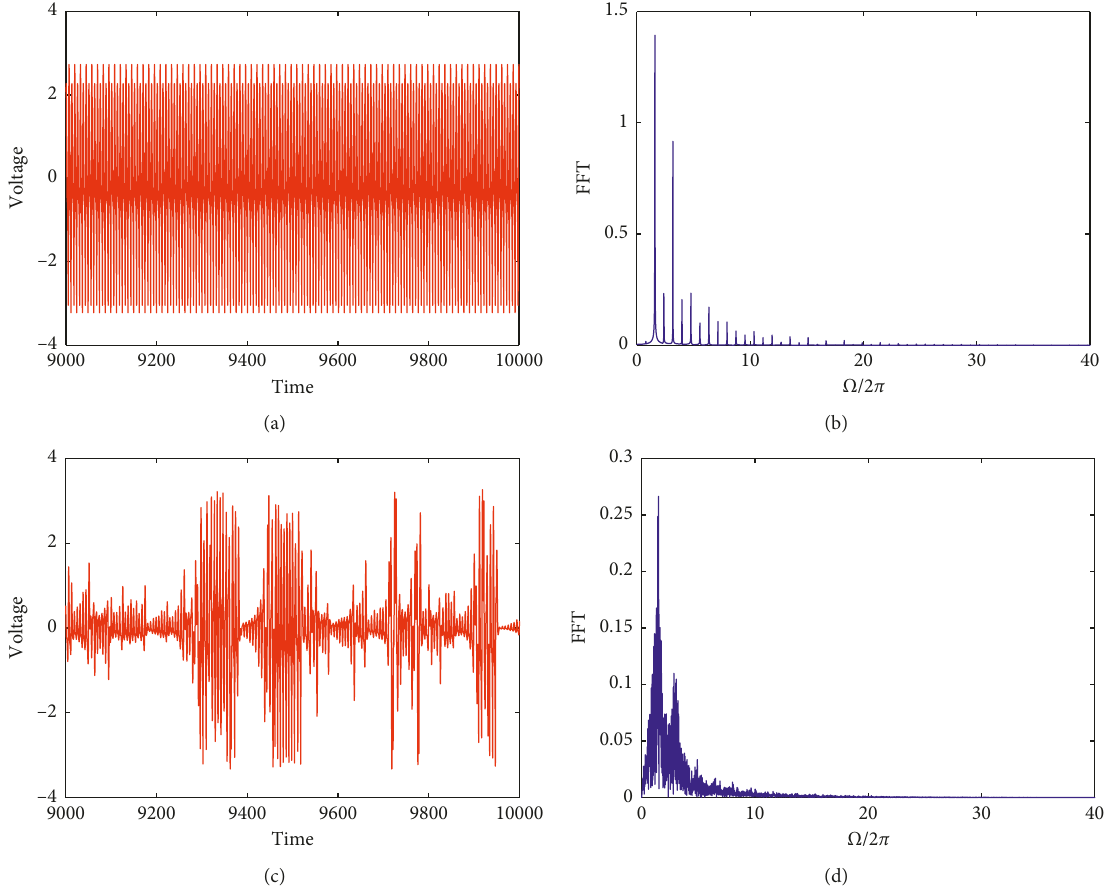
Figure 11: Response of the energy harvester for f � 2 . 22: (a) time-domain output voltage for c � 0 . 0; (b) spectrum of the time-domain output voltage for c � 0 . 0; (c) time-domain output voltage for c � 0 . 1; (d) spectrum of the time-domain output voltage for c � 0 .